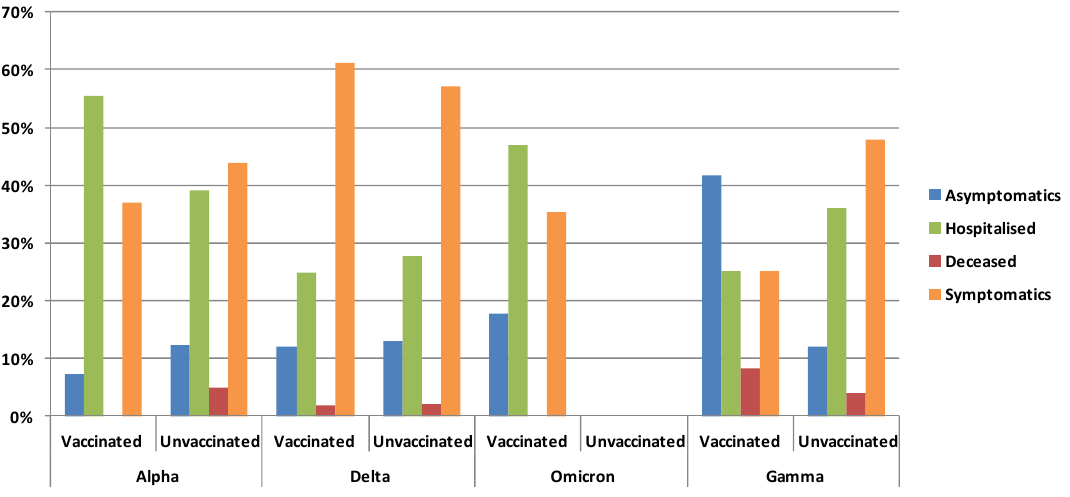
Figure 5. Proportion of clinical status in the vaccinated and unvaccinated subjects infected with the different variants.